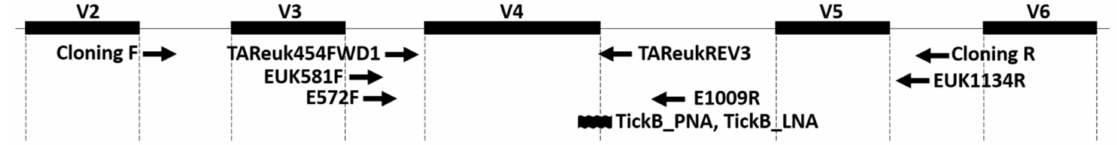
Figure 1. Locations of the primers/blockers used in this study. The upper horizontal bars indicate the hypervariable regions (V2, V3, V4, V5, and V6) of 18S rRNA gene. Each arrow indicates the position and orientation of the primer, while a wavy line represents the position of the blockers. Primer/blocker names are provided next to the arrows or the wavy